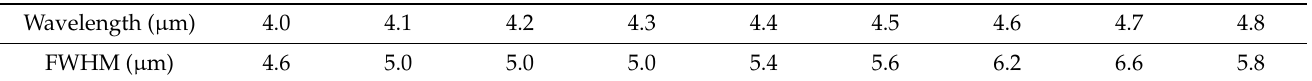
Figure 5. Simulated normalized intensity profiles in the xy-plane (left panels of ( a – i )) at the fixed position of z = 200 μm, i.e. , the designed focal plane, at wavelengths from 4.0 μm to 4.8 μm (spaced by 0.1 μm) ( a – i ), showing strong focal spots with weak sidelobes. Simulated normalized light intensity along the x-axis (right panels of ( a – i )) at the focal plane, i.e., the horizontal cuts of the focal spots. Table 3. FWHMs at wavelengths from 4.0 to 4.8 μm.